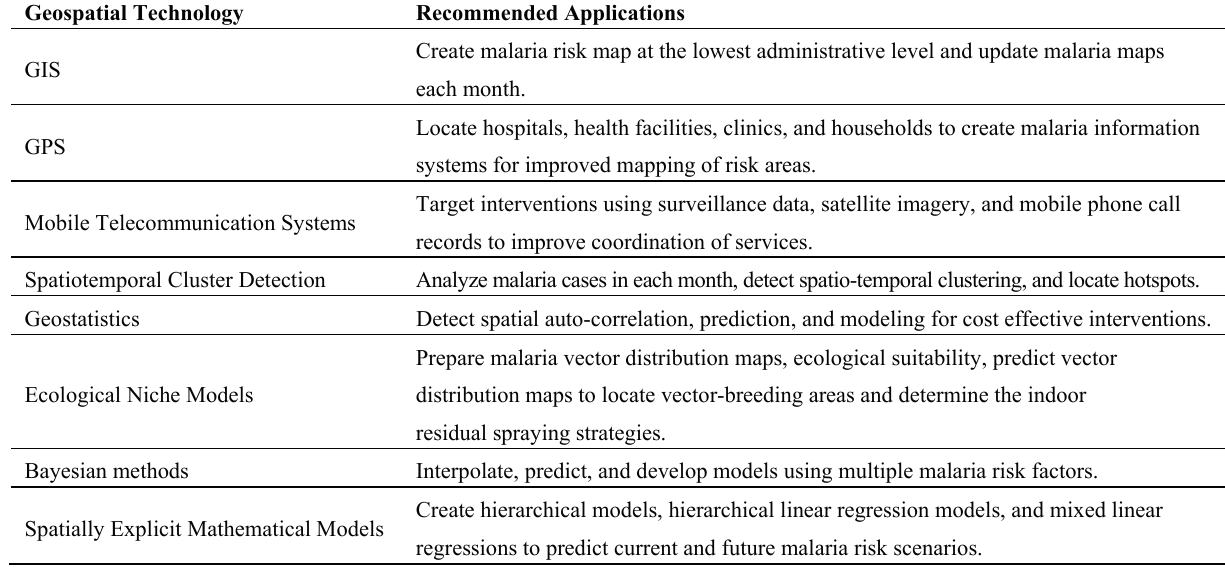
Table 2. Recommended Geospatial Technologies to use toward Malaria Elimination in